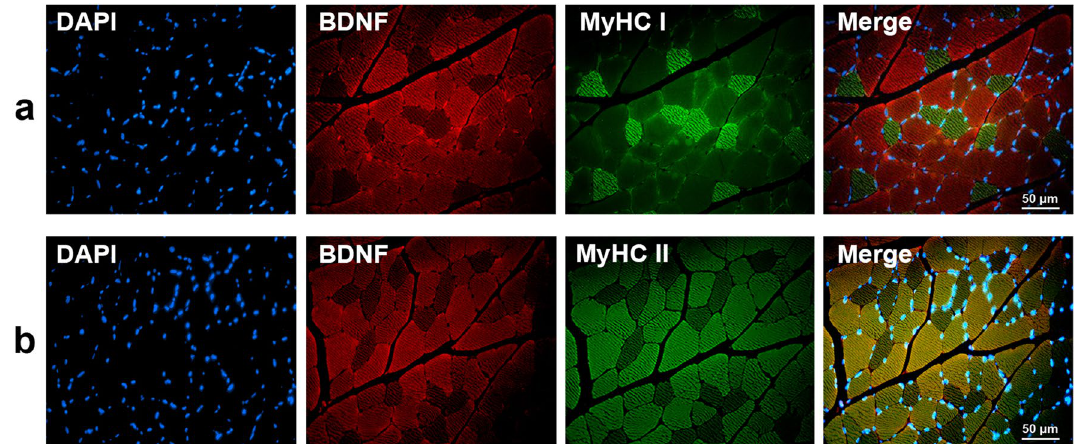
Figure 3. Colocalization of BDNF with slow-type (MyHC I, a ) and fast-type fibers (MyHC II, b ) in gastrocnemius (GAS) muscle. DAPI (blue) and MyHC I/II (Myosin Heavy chain I/II, green) were used as nuclear and slow I (MyHC I)/fast II (MyHC II) myosin isoform markers, respectively. Red-labelled immunofluorescence represents BDNF. A great BDNF staining in fast-type fibers was visualized in GAS muscle. Similar results were observed in all examinations ( n = 4). Scale bar 50 µm.